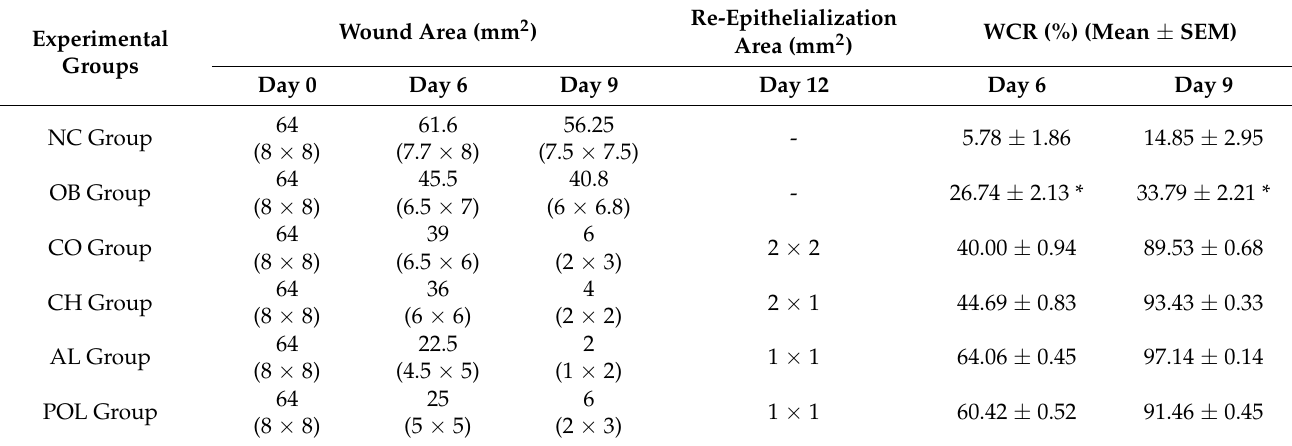
Table 2. Evaluation of wound area, re-epithelialization area and wound. Contraction rate (WCR) for the excision model.